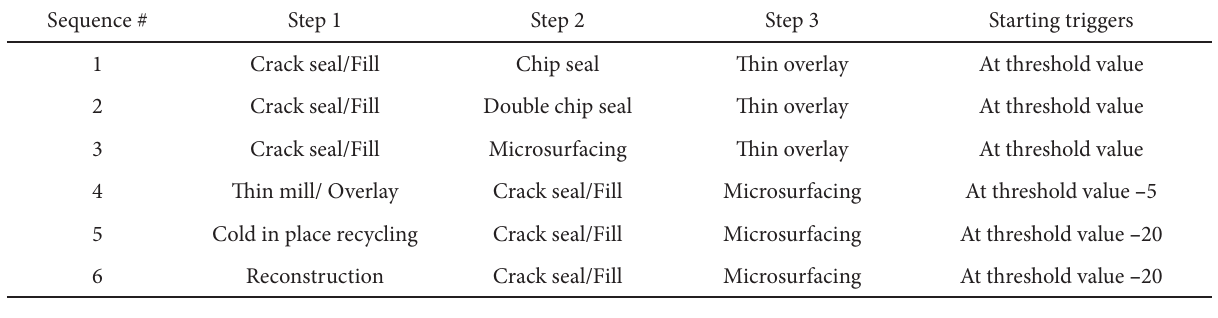
Table 4. Six treatment sequences